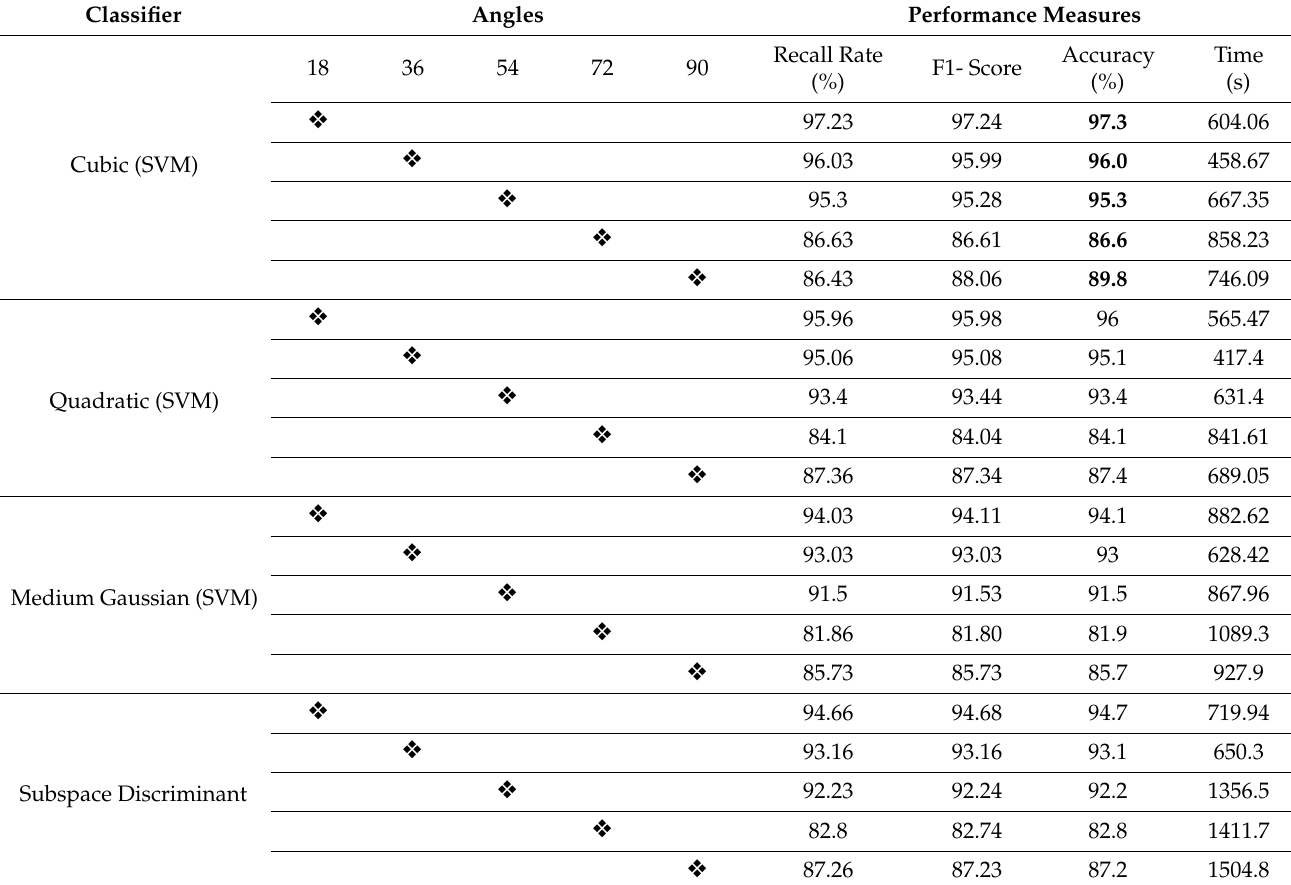
Table 3. Gait recognition results using modified NasNet-Mobile on selected angles of the non-augmented CASIA B da- taset.